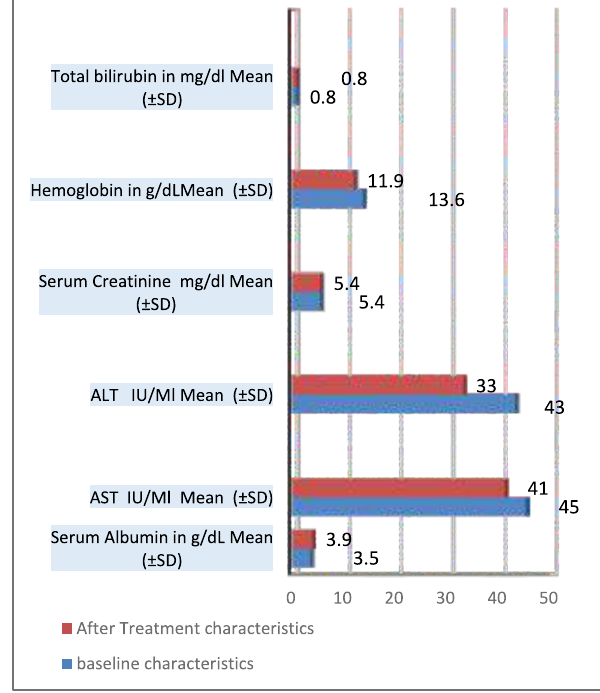
Figure-II: Therapy efficacy before and after drug